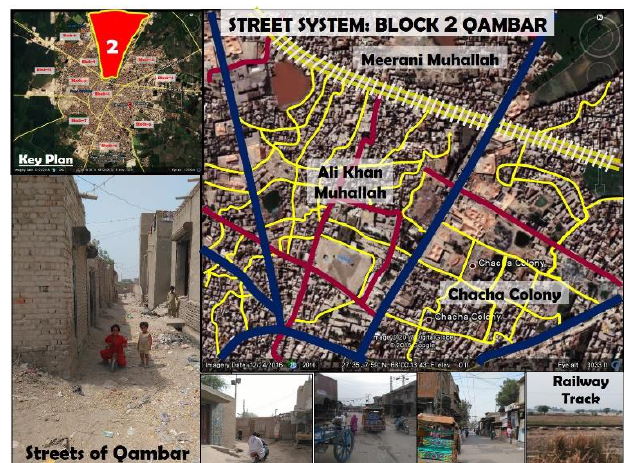
Fig. 4. Typo–Morphological analysis of Qambar: division of city in component parts as eleven urban block